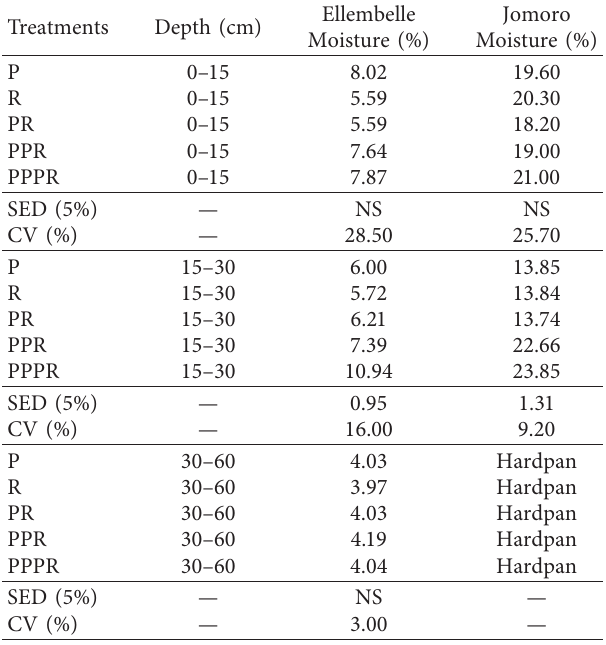
Table 8: Effect of plantain population density on soil moisture content in plantain-rubber intercropping system at Ellembelle and